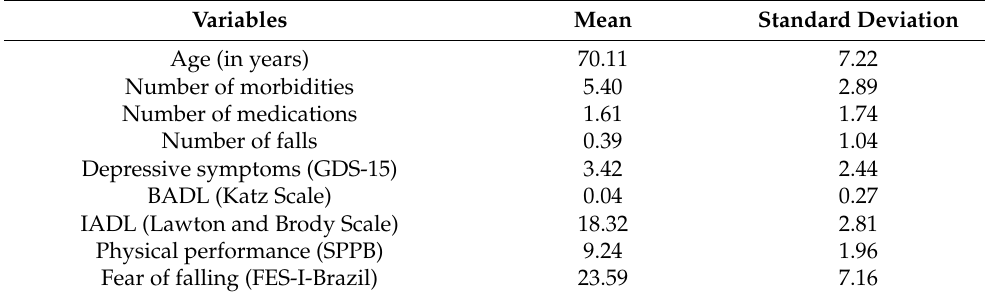
Table 2. Distribution of means and standard deviations of quantitative variables included in the structural model among community-dwelling older adults (Macap á , Amap á , Brazil, 2017) ( n = 410).